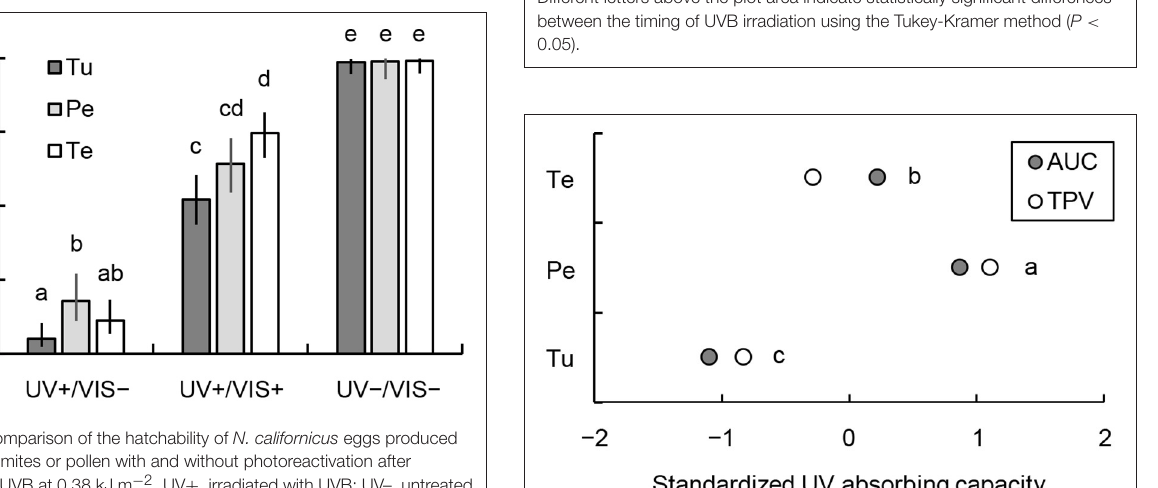
FIGURE 5 | Standardized UVB-absorbing capacity of methanol extracts from T. urticae (Tu), peach pollen (Pe), and tea pollen (Te). UVB-absorbing capacity measured as the area under the curve (AUC) of UV spectra at 280–315nm wavelength by a spectrophotometer and total peak integral values (TPV) by high-pressure liquid chromatography (HPLC) equivalent to fresh weights. Different letters at the right of the plots represent statistically significant differences (Tukey method, P < 0.01).